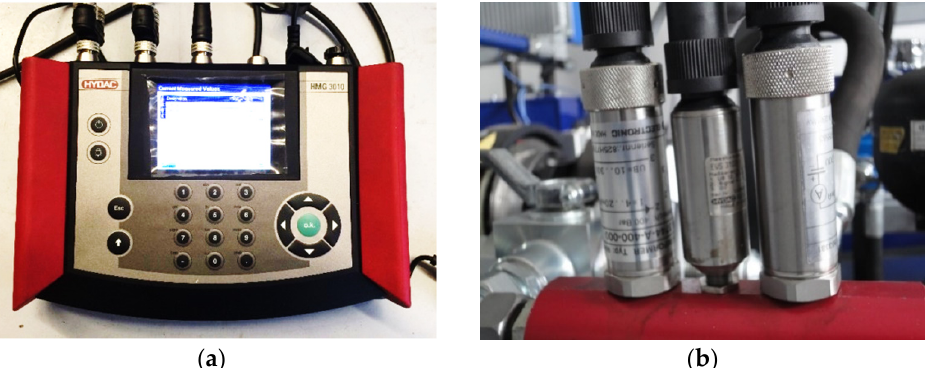
Figure 2. ( a ) Measuring device HMG 3010; ( b ) flow, pressure, and temperature sensors for HMG measuring device.